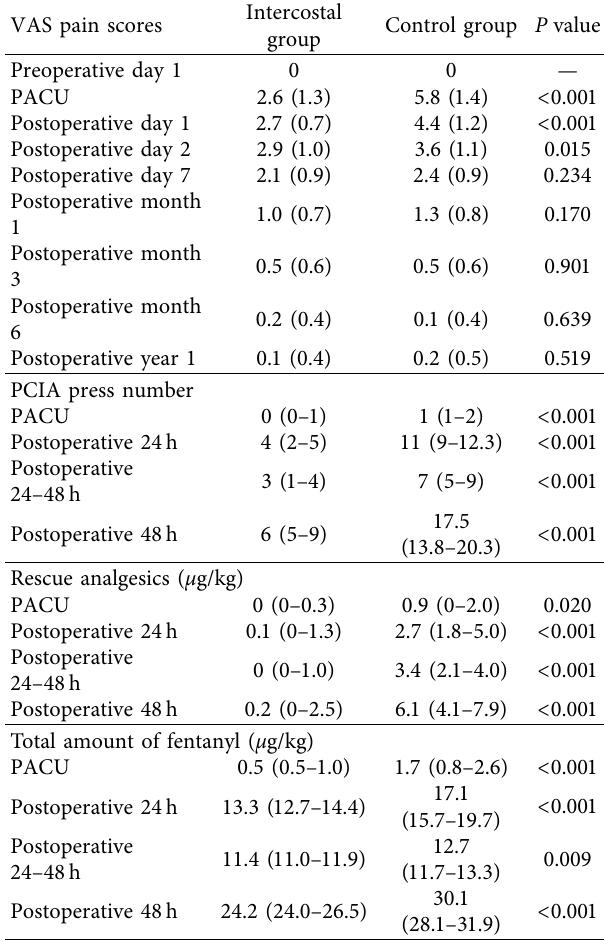
Table 3: Comparison of pain-related outcomes between the two